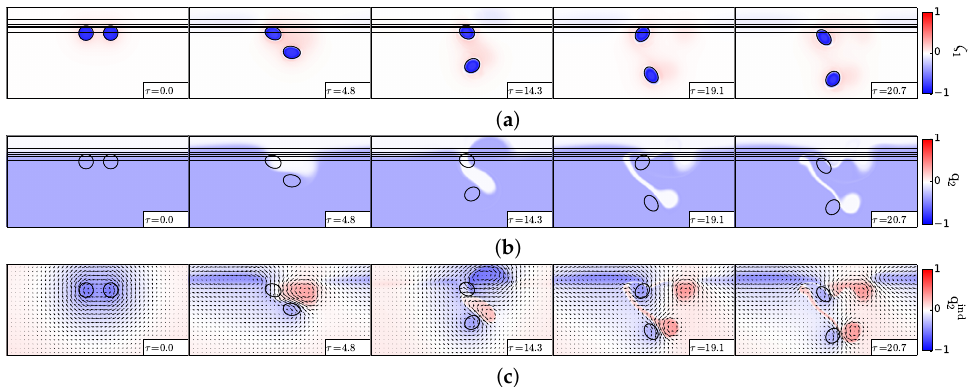
Figure 18. Drift of two anticyclones away from the slope for d / R = 3.4, γ R = 1, d c / R = 1. ( a ) Upper layer relative vorticity (Equation (3)); ( b ) lower layer potential vorticity (Equation (2)); ( c ) lower layer velocity and “equivalent barotropic” potential vorticity (Equations (4) and (11)). In (a,b), the black contours indicate the topographic slope (Equation (12); straight lines) and the upper layer vorticity contours showing the two vortex evolution.